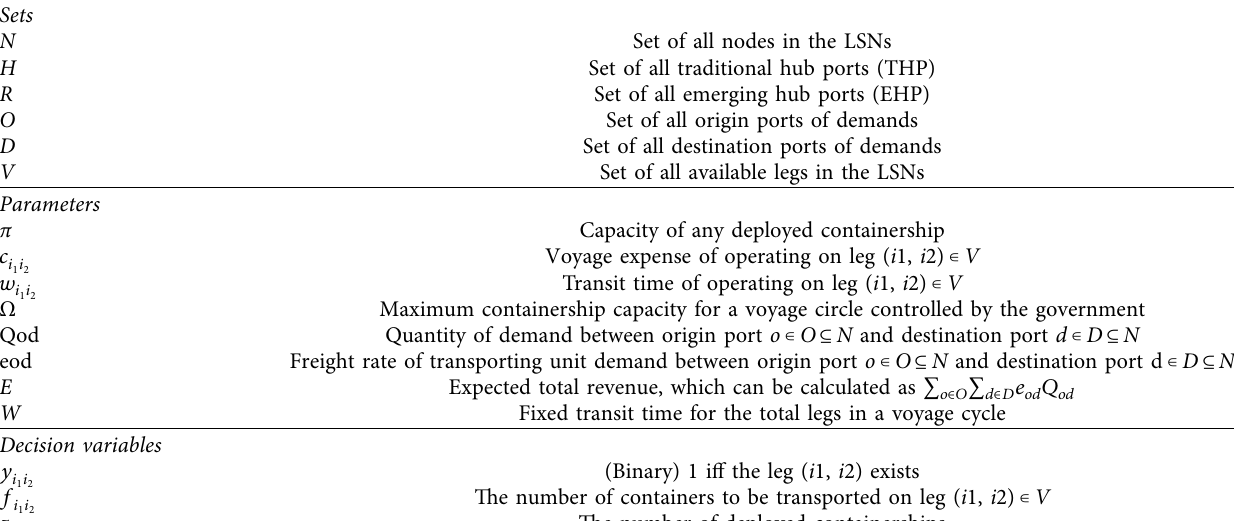
Table 1: Notations of model in NA